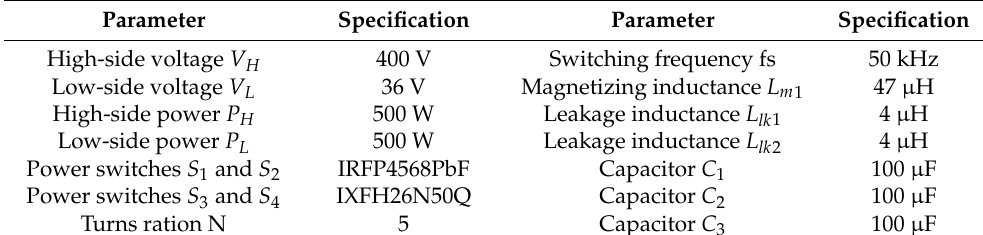
Figure 12. Photograph of the proposed topology.